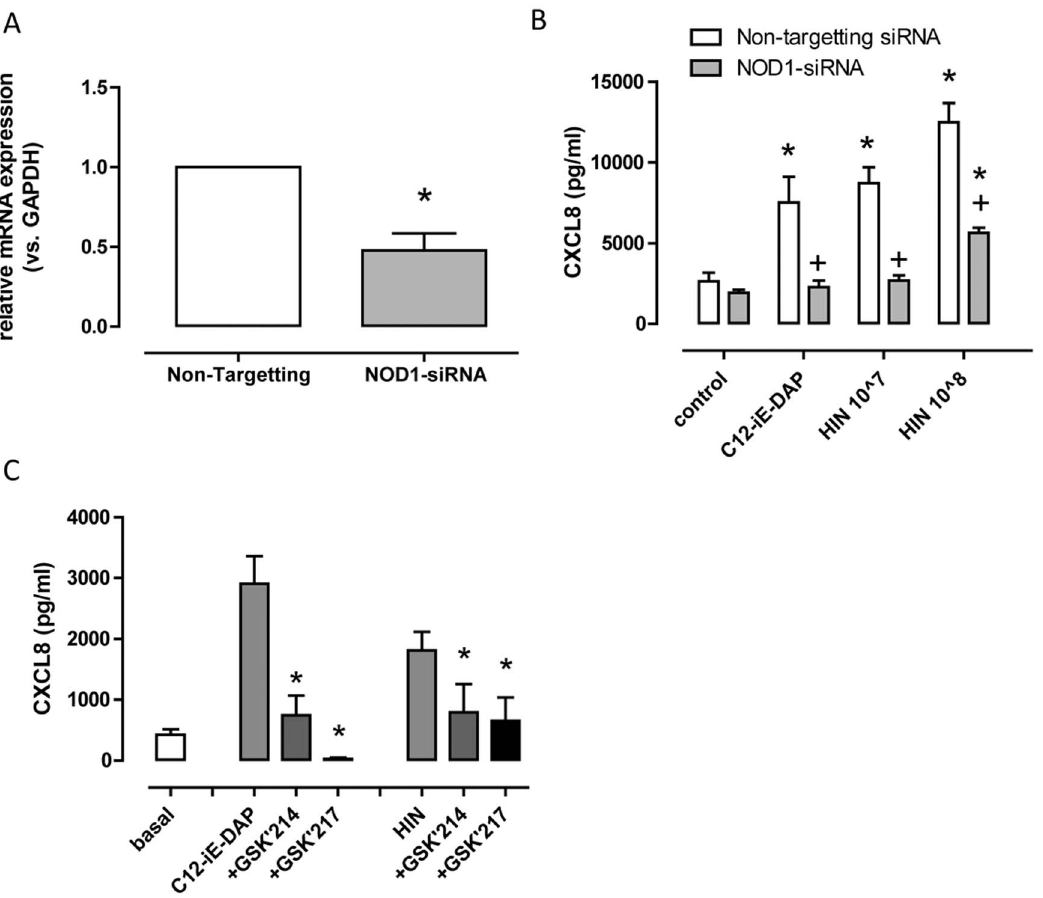
Figure 4. Effect of pharmacological inhibition of RIP2 and NOD1 siRNA mediated knockdown on responses of hESC-EC to Haemophilusinfluenzae (HIN) and C12-iE-DAP. (A) Relative expression (vs. GAPDH) of NOD1 following 48 hour incubation with NOD1 siRNA normalized to non-targeting siRNA; n=6. (B) CXCL8 release from hESC-EC following 48 hour pre-incubation with non-targeting siRNA (open bars) or NOD1-siRNA (filled bars) and 24 hour treatment + / 2 C12-iE-DAP (10 m g/ml) or Haemophilus influenzae (HIN) (10 7 –10 8 CFU/ml); n=7–8. (C) Effect of GSK’214 (300 nM; RIP2 inhibitor) or GSK’217 (300 nM; NOD1 inhibitor), given 30 minutes before a 24 hour treatment with HIN (10 7 CFU/ml) or C12-iE- DAP (10 m g/ml) on CXCL8 release; n=4. It should be noted that GSK drugs increased CXCL8 release under basal conditions; for each experiment this was subtracted from treatment groups. For panel A, statistical significance was determined by one-sample t-test. For panel B statistical significance within siRNA groups was determined by one-way ANOVA followed by Dunnett’s multiple comparison test (*p , 0.05), and between groups by two- way ANOVA followed by Bonferroni’s post-test ( + p , 0.05). For panel C statistical significance for the effects of inhibitor of C12-iE-DAP or HIN induced CXCL8 was determined by one-way ANOVA followed by Dunnett’s multiple comparison test (*p ,